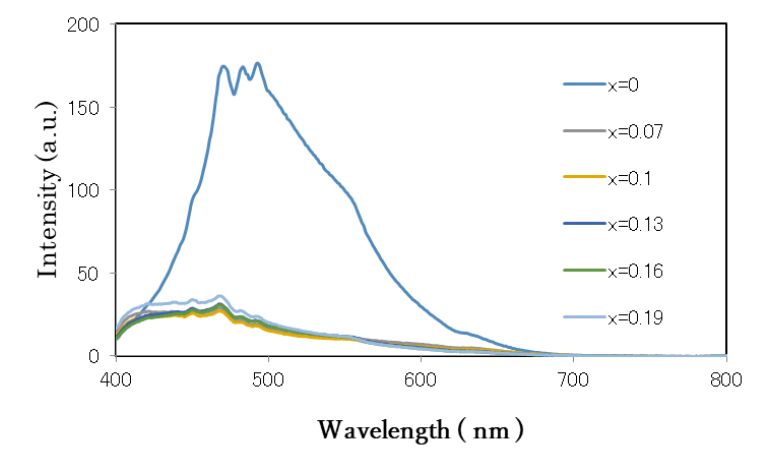
Figure 5. Photoluminescence spectra for Zn (1−2x) (CuGa) x In 2 S 4 excitation: 350 nm.